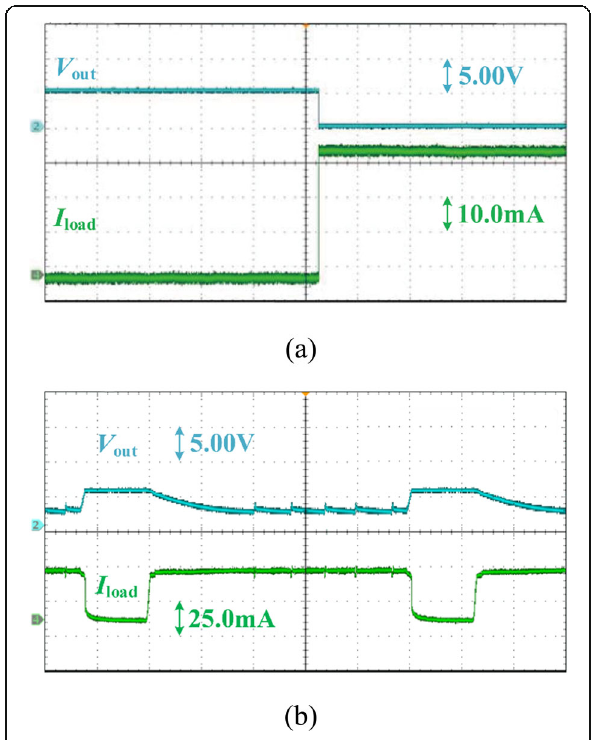
Fig. 14 The OCP measurement of proposed VR. a output short circuit; b transient between overcurrent and normal load